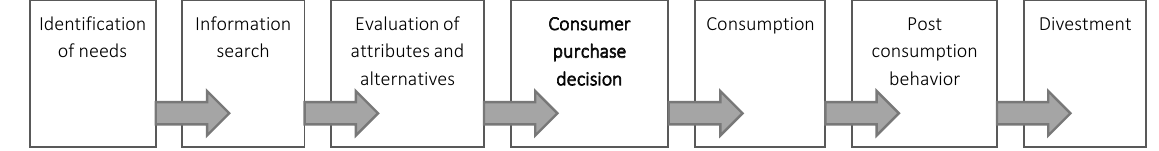
Figure A1. Consumer purchase decision